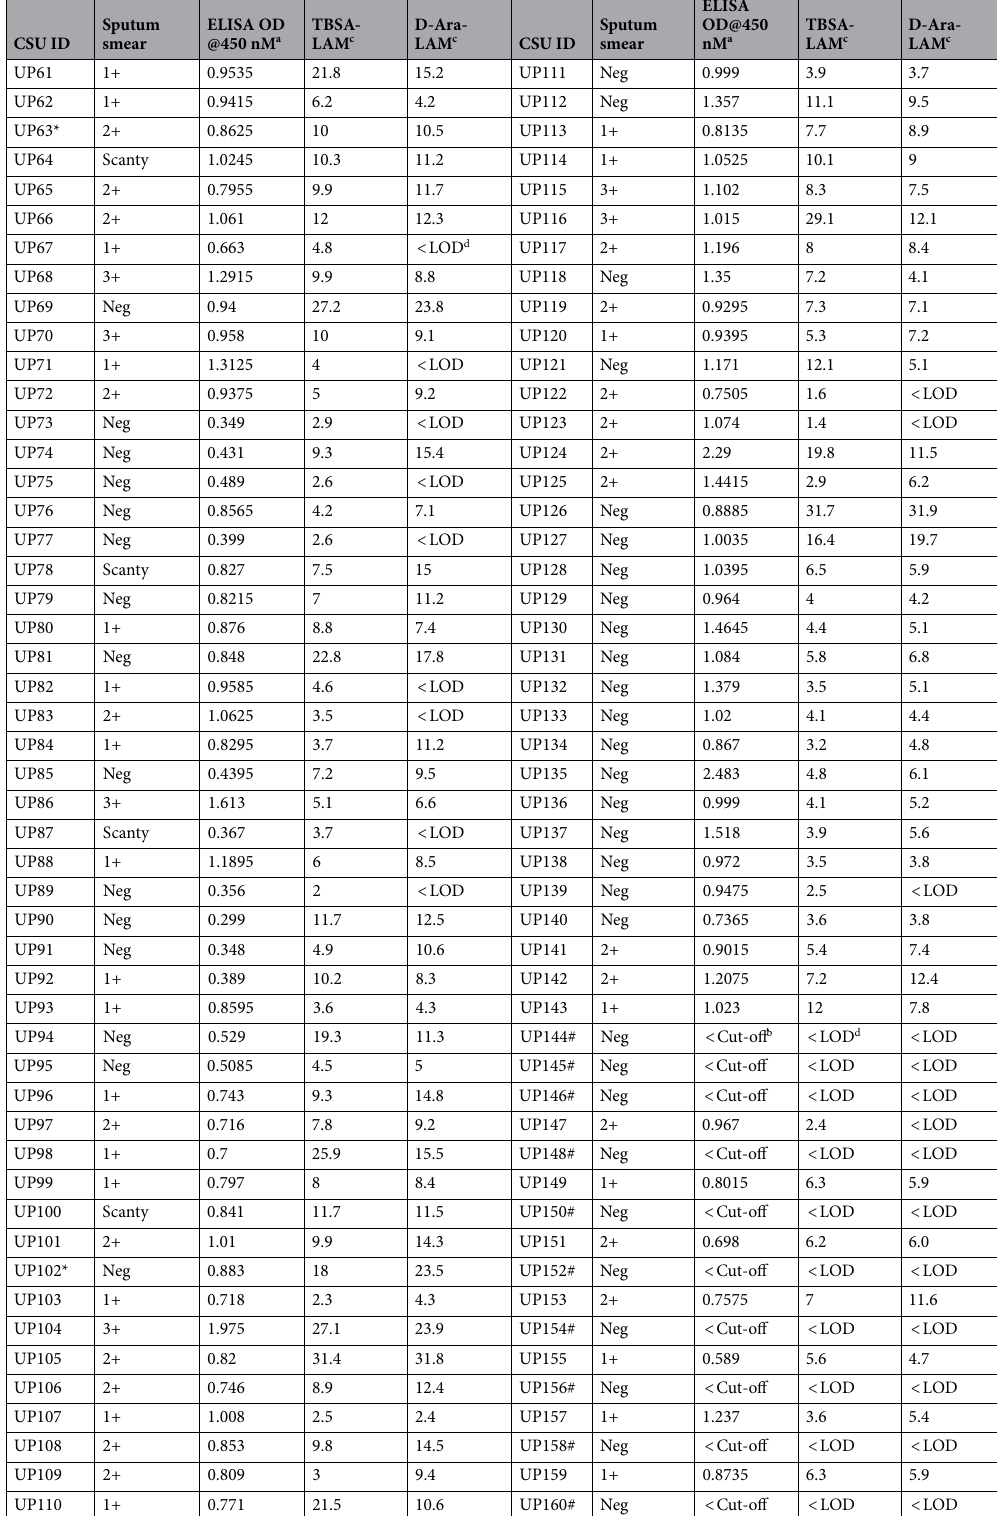
Table 3. Follow-up cohort of 100 patient’s urine samples from Peru. 90 were sputum culture positive adult TB patients. #10 Culture negative, smear negative TB negative pediatric control from same endemic region. *Only 2 (UP63, UP 102) samples were from HIV infected person. a ELISA was done using CS35 as capture and A194-biotin as detection antibodies and recorded at 450 nM. b ELISA cut-off was set at OD value 0.289. c LAM concentration determined by measurement of tuberculostearic acid (TBSA) and d-Arabinose (d-Ara) and presented in ng/mL. d LOD for d-ara-LAM was 2.4 ng/mL and TBSA-LAM was 2.0